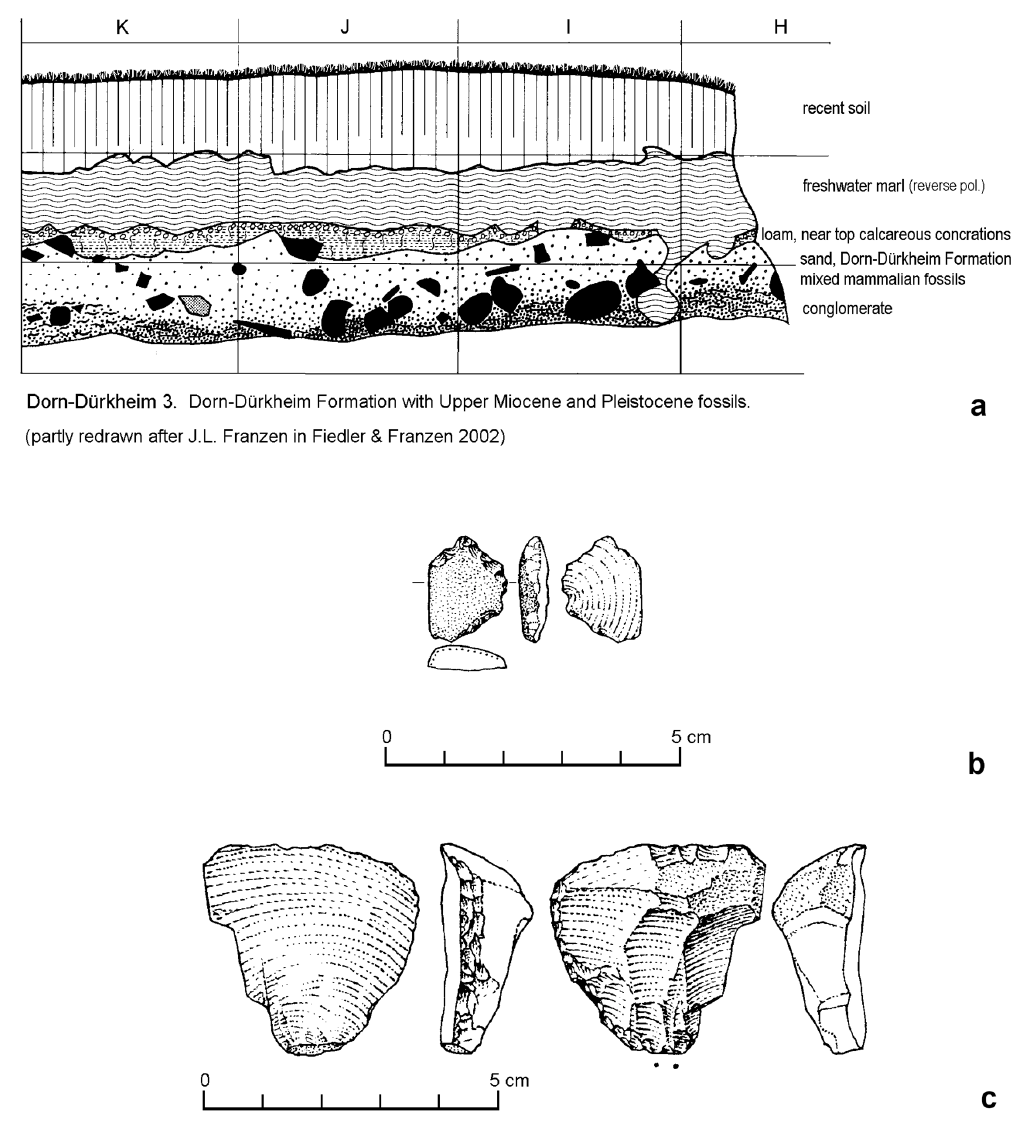
Figure 12. Dorn-Dürkheim 3. ( a ) The stratigraphy; ( b ) drill out of a quartz flake; ( c ) scraper out of quartzite. (Partly redrawn after Fiedler and Franzen 2002.).